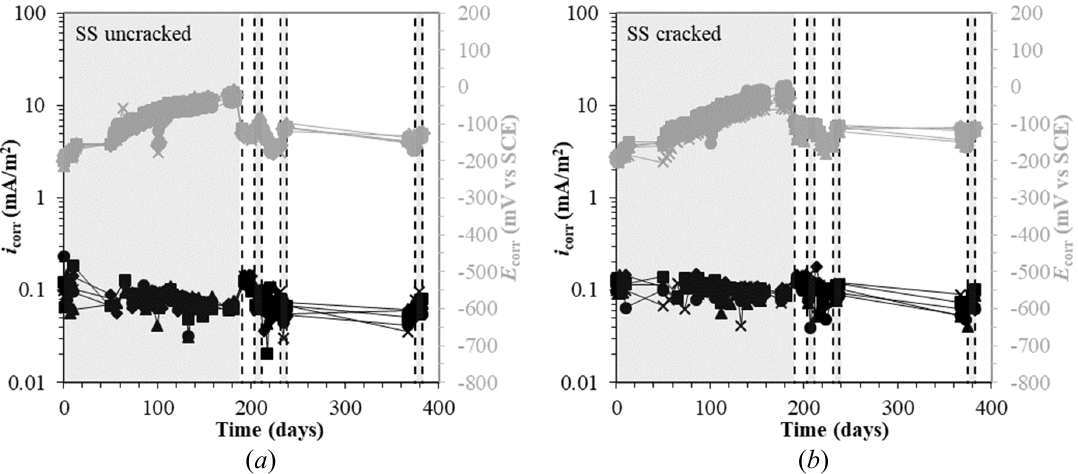
Figure 3. Evolution in time of the corrosion potential (grey symbols) and corrosion current density (black symbols) of 304L stainless steel rebars embedded in the five replicate uncracked (a) and cracked (b) concretes and exposed to ponding with a 3.5% NaCl